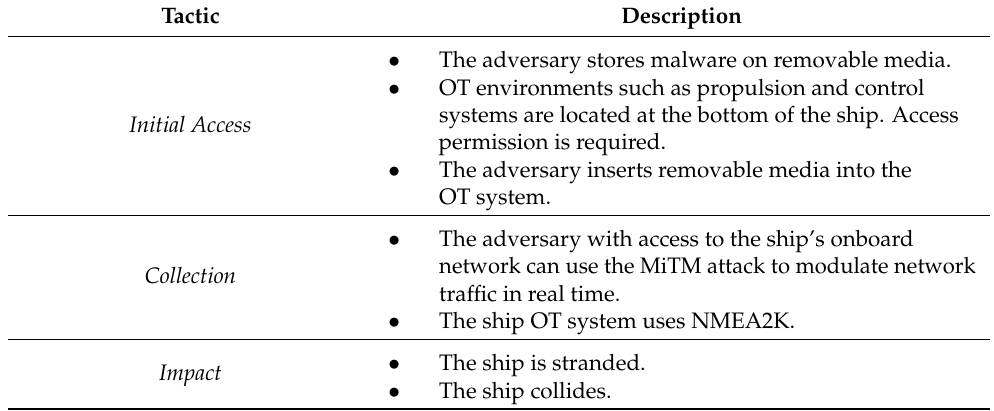
Table 8. Propulsion, machinery, and power control system analysis results.